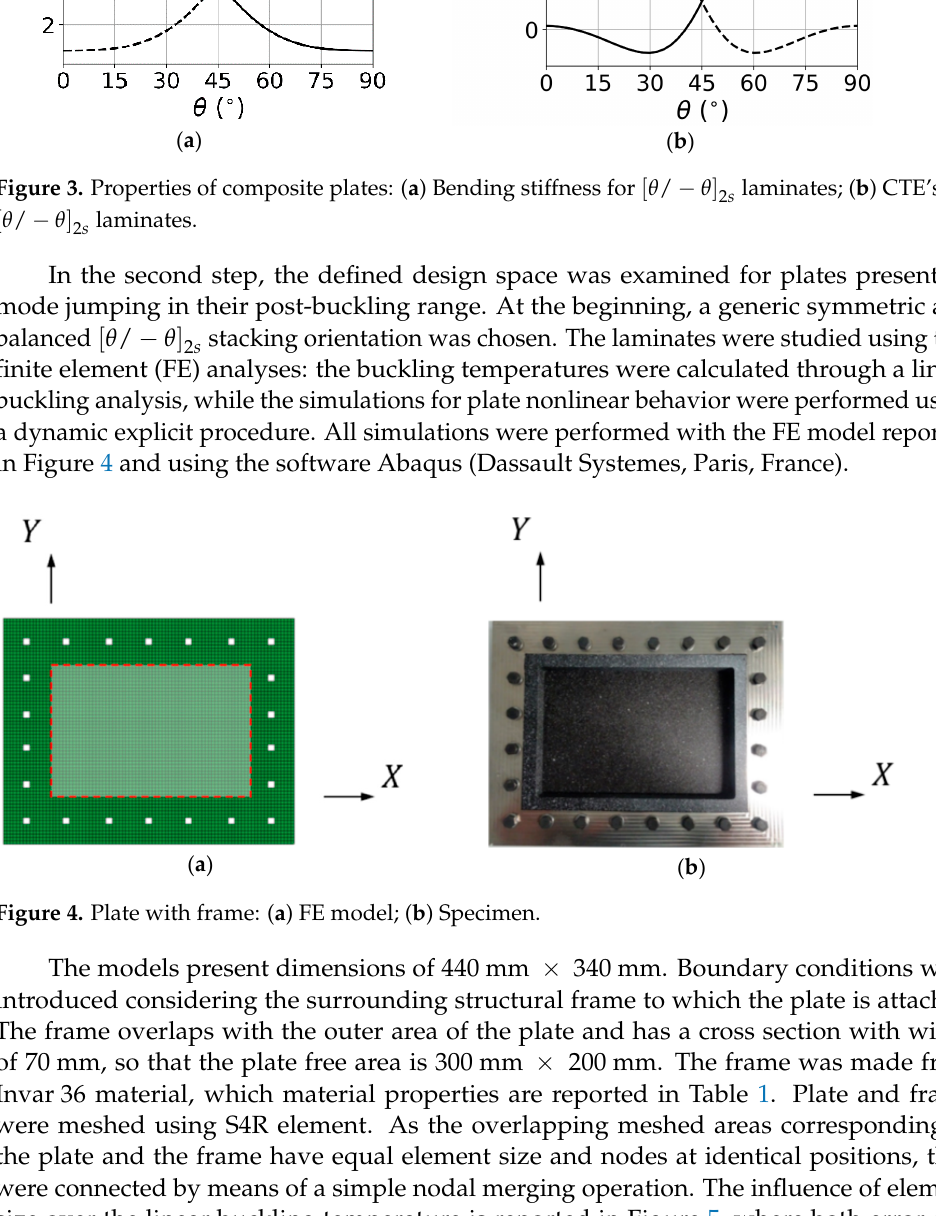
laminates; ( b ) CTE’s for 2 s